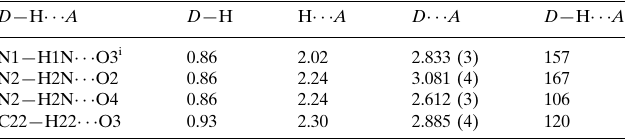
Hydrogen-bond geometry (A˚ , (cid:1)